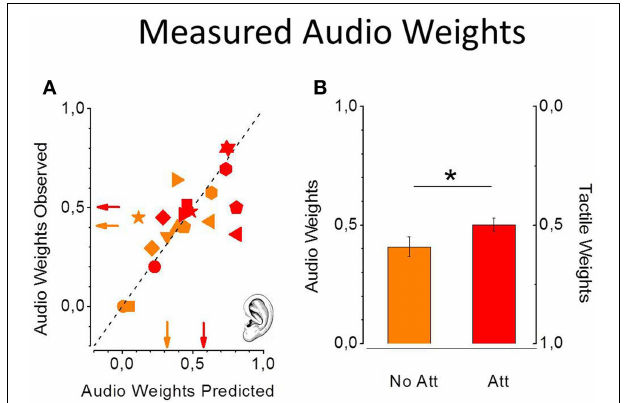
FIGURE 5 | Predicted and observed individual auditory weights from the 10 participants in the non-attentional (light red) and the attentional (dark red) condition (A). Standard errors were computed with bootstrap simulation. Data are all scattered on the equality line meaning perfect prediction from the MLE model. Measured average auditory weights are higher in the attentional condition (B) . ( * p - value < 0 . 05 ).